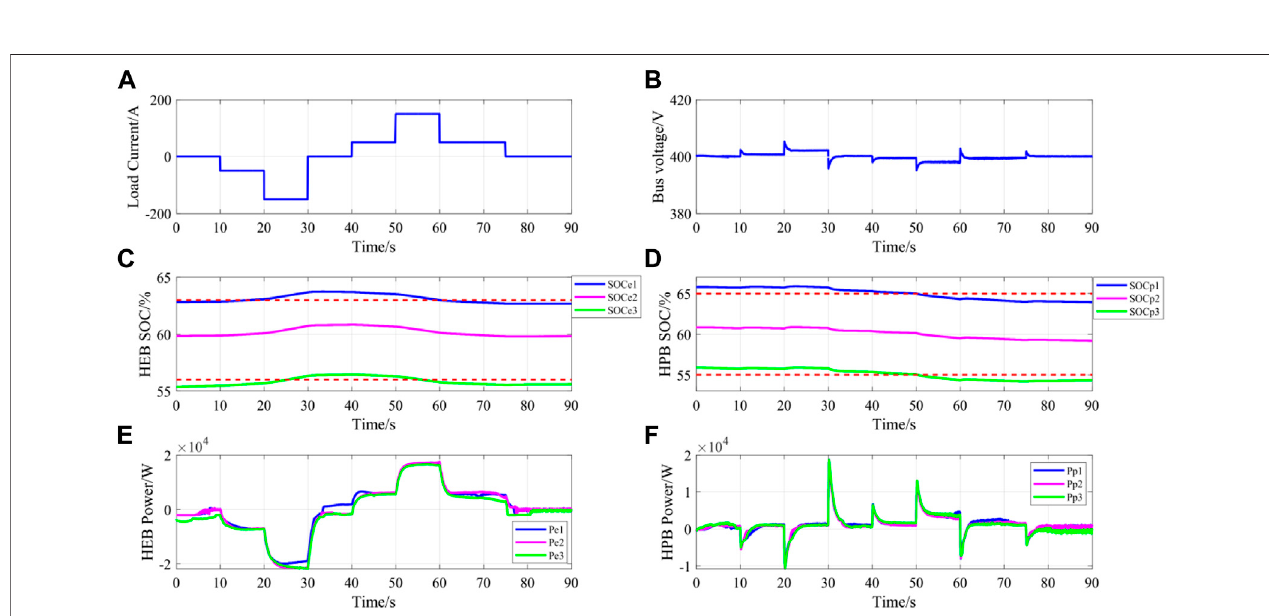
FIGURE 14 | Simulation results when No. 1 High-Energy Battery fault: (A) Bus voltage; (B) High-Energy Battery SOC; (C) Output power of High-Energy